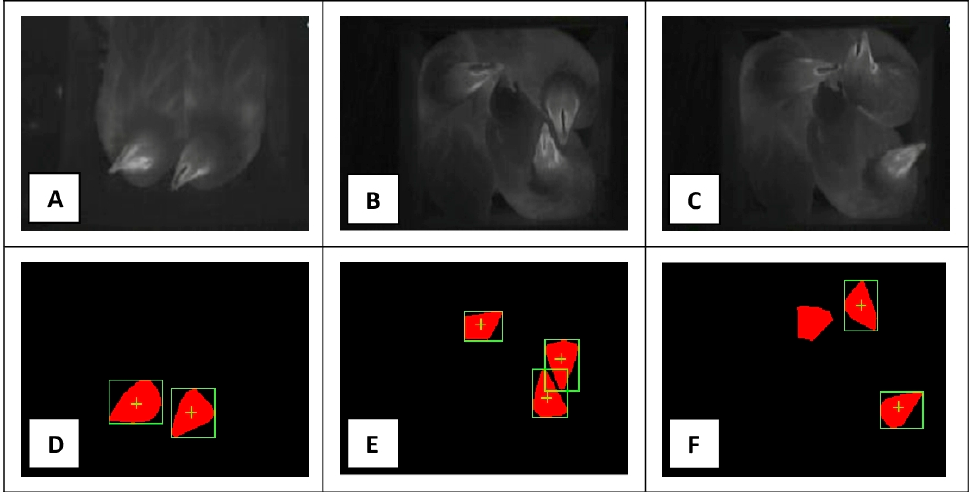
Figure 5. The pictures ( A – C ) are thermografic images acquired by the “nest-usage-sensor” from the nest interior; The pictures ( D – F ) are the results of the image pattern recognition procedures performed by the sensor having as input the images ( A – C ); Picture ( D ) is an example of a true-positive case considering the detection of a multiple or double nest occupation and, in the same time, an example of a true-negative case if the detection of a triple nest occupation is evaluated; Picture ( E ) is an example of a true-positive case, when considering the detection of a multiple or triple nest occupation, and an example of a true-negative case for the detection of a double nest occupation; Finally, picture ( F ) is an example of a true-positive case about the detection of a multiple nest occupation; of a false-positive case for the detection of a double nest occupation and of a false-negative case if the detection of a triple nest occupation is taken into consideration. Table 5. Performances of the sensor in the detection of a multiple occupation of the nest during an oviposition.